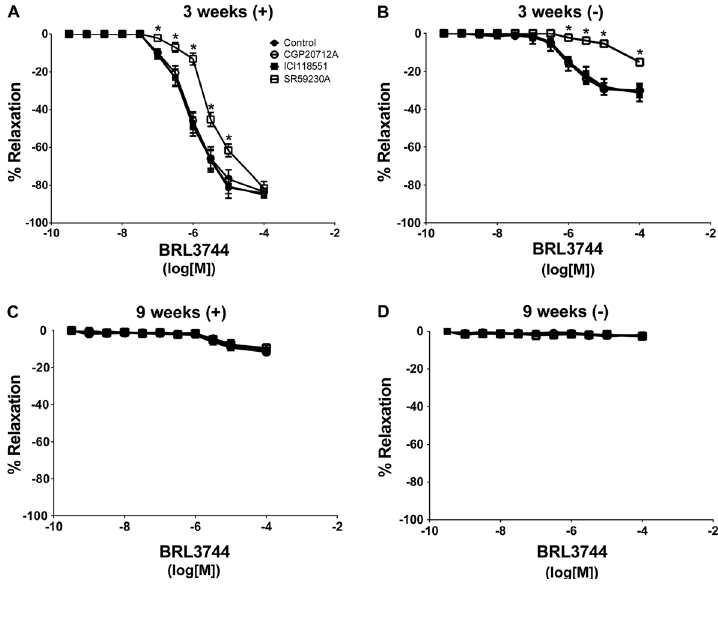
Figure 4. Comparative analysis of b -adrenergic receptor protein expression in aortic tissue of 3- and 9-week-old rats. The western blot is representative of 5 different experiments for each speci fi c b receptor, with actin used as control ( A ). Graph represents the b -adrenergic receptor/actin ratio of 3- and 9-week-old rats ( B ). Data are reported as the mean ± SE of 5 different rats. *P o 0.05 vs 3-week-old rats (one-way ANOVA followed by Newman Keuls